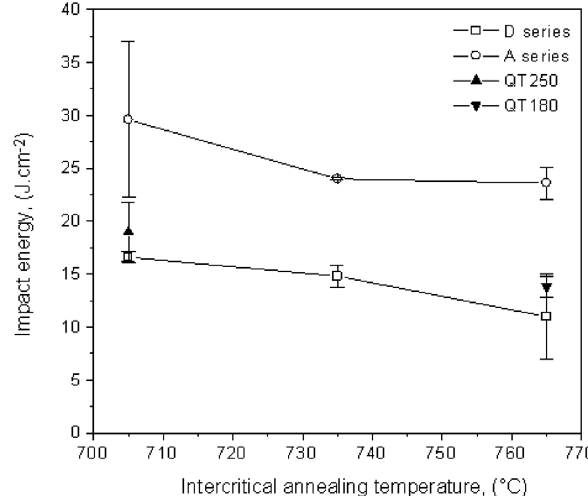
Fig. 2: Changes in the impact toughness of the specimens with intercritical annealing